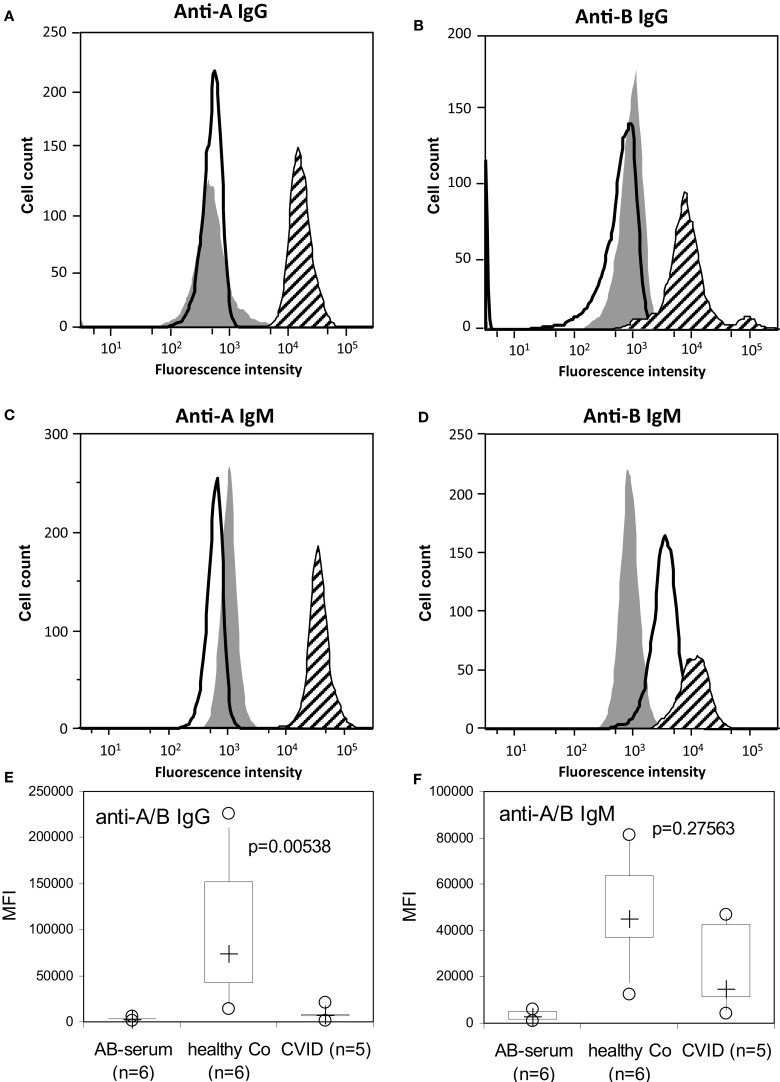
Detection of anti-A/B IgG- and IgM-antibodies by flow cytometry. The anti-A/B IgG and IgM mean fluorescence intensity (MFI) histograms of a representative CVID patient (bold lines) with no anti-A/B IgG (A,B), no anti-A IgM but with anti-B IgM present (C,D), and a healthy individual (hatched histograms) with anti-A/B IgG (A,B) and anti-A/B IgM present (C,D) are depicted. Background binding of fluorescence-labeled anti-IgG and anti-IgM was assessed using AB serum [(A–D), filled histograms] containing no or only low levels of anti-A/B IgG-(A,B) and IgM-antibodies (C,D). The X-axis represents the MFI given on a logarithmic scale and the Y -axis the cell number on a linear numeric scale. Defective anti-A/B IgG (E) but normal IgM (F) antibody response in patients with CVID and controls (healthy Co) as examined by flow cytometry. Background binding of fluorescence-labeled anti-IgG and anti-IgM to the erythrocytes was assessed in the presence of an AB serum containing no or only low levels of anti-A/B antibodies. Box plot diagrams show anti-A/B IgG (E) and IgM (F) antibodies in serum with the median of the study group represented by a cross, the interquartile range (IQR) represented by the box, 5- and 95-percentile values represented by the whiskers, and minimum and maximum values depicted by circles. The non-parametric Mann–Whitney U-test (two-sided P value) was used for statistical comparison between patients and healthy control subjects.